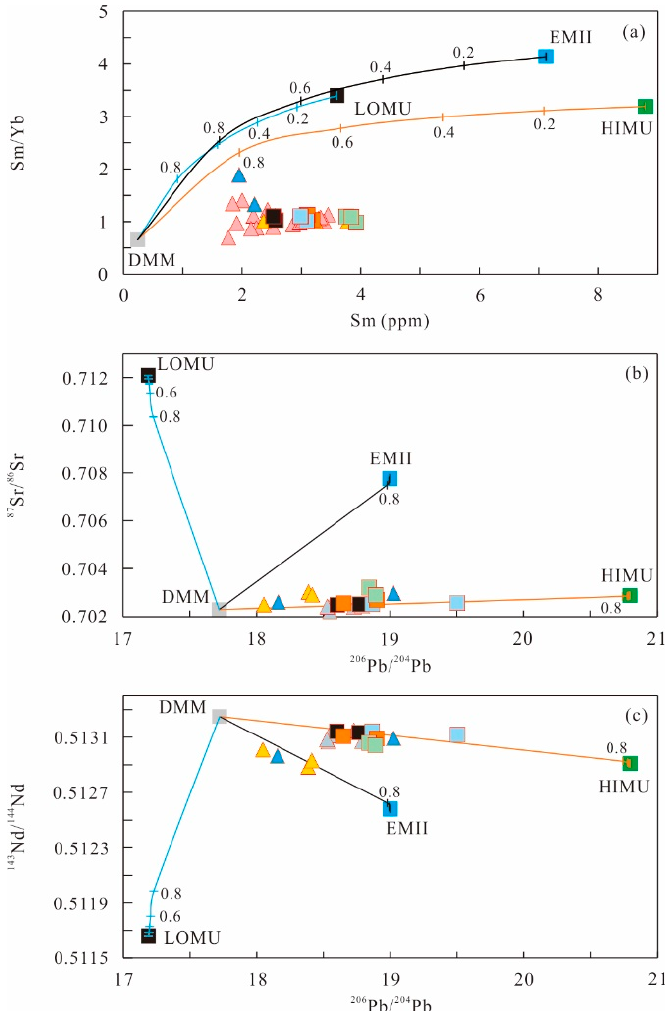
Figure 8. Diagrams of Sm versus Sm/Yb ( a ), 206 Pb/ 204 Pb versus 87 Sr/ 86 Sr ( b ), and 206 Pb/ 204 Pb versus 143 Nd/ 144 Nd ( c ). The calculated binary mixing lines are shown between the DM, HIMU, EMII, and a LOMU component. The endmember compositions used are shown in Table 3. The numbers on the mixing lines indicate the percentage contribution of the DM components. Symbols are the same as in Figure 2. Table 3. Trace element (ppm) and isotope compositions of mixing model components.